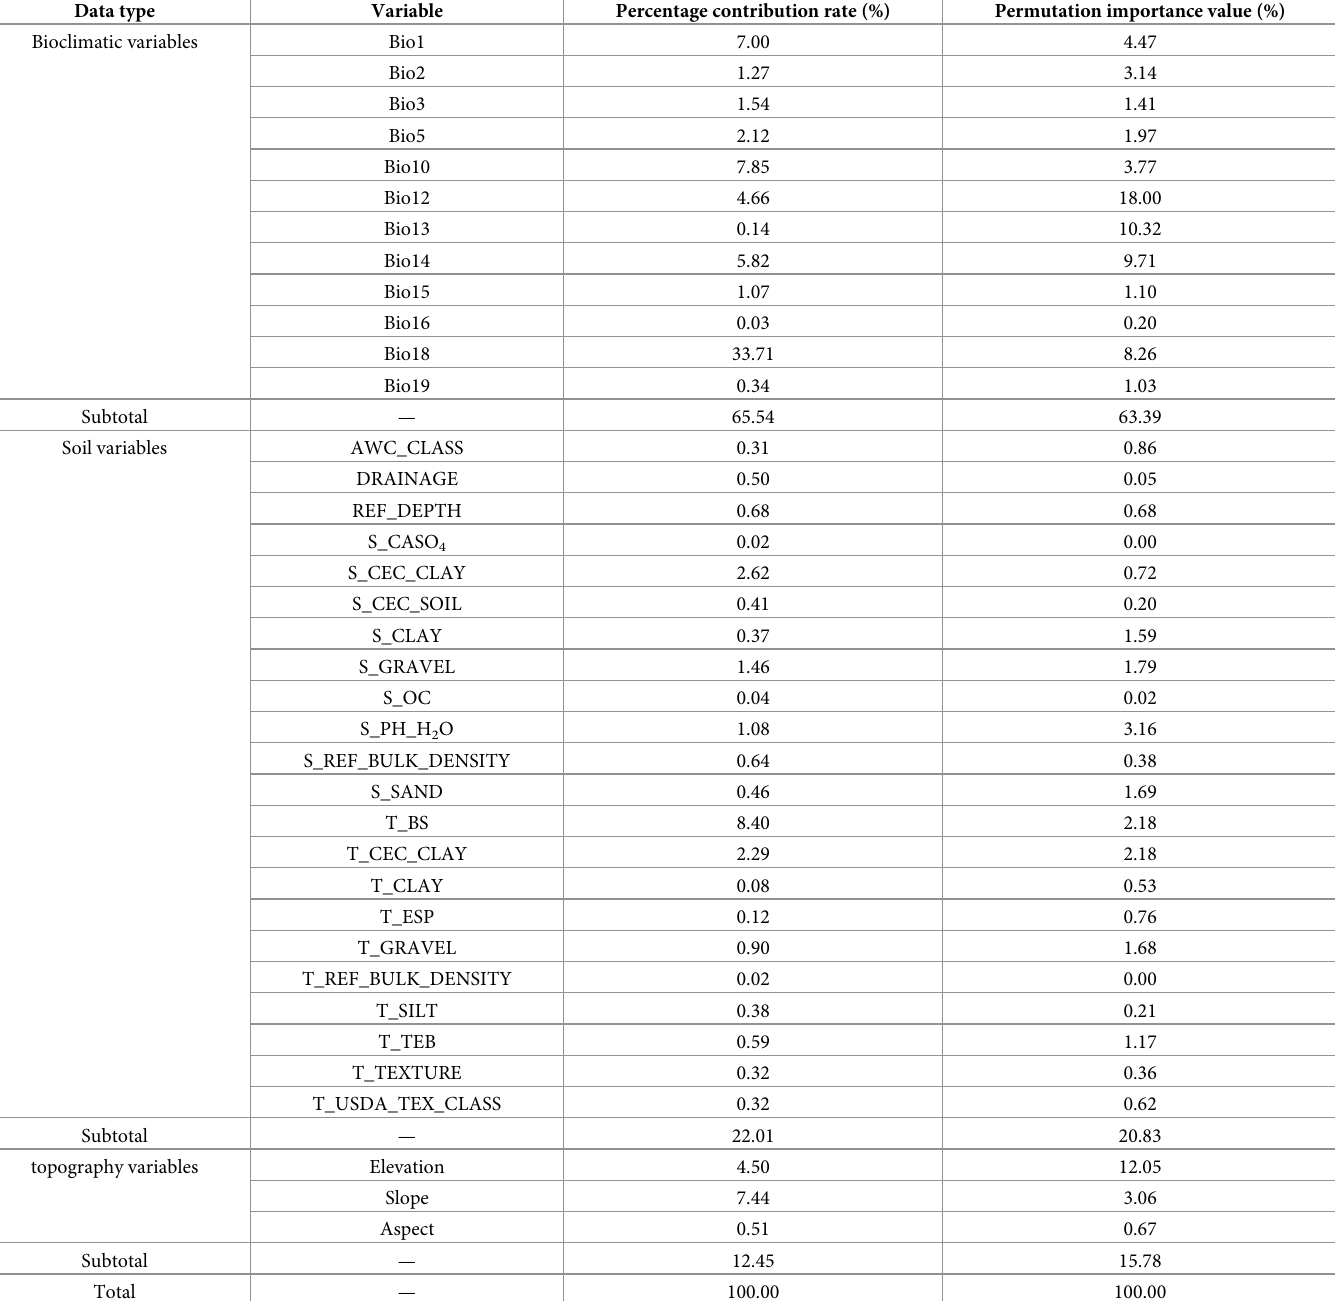
Table 1. Percentage contribution rate and permutation importance value of the environmental variables used to predict the potential geographical distribution of Betula platyphylla